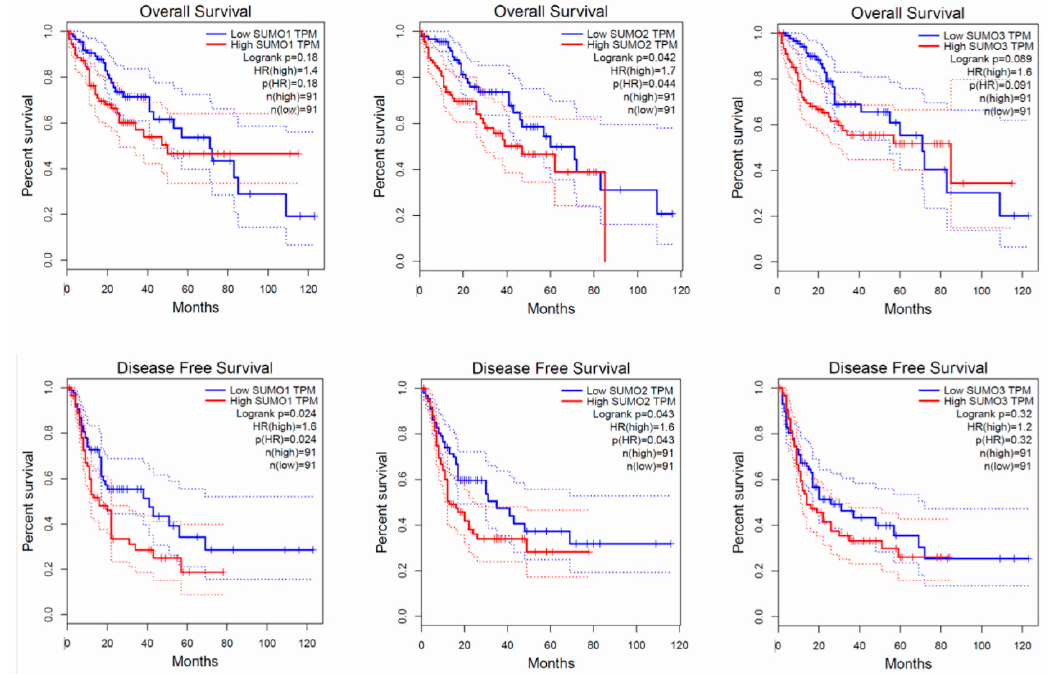
Figure 4. The prognosis value between the expression of SUMOs mRNA. The red line in the figure below represents patients with high expression of SUMOs mRNA and the blue line represents patients with low expression. Use 75% as the high cut-off and 25% as the low cut-off. Patients with low expression of SUMO protein had better OS and DFS than patients with high expression.